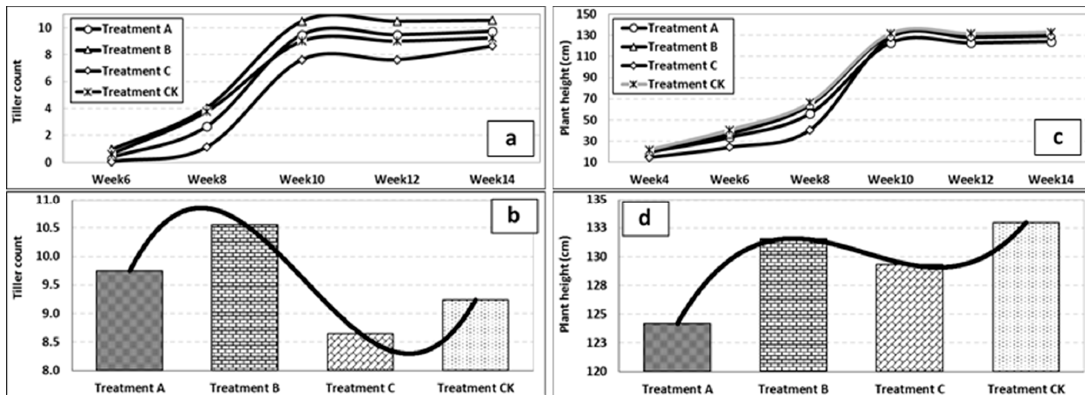
Figure 3. Number of tillers from the 6th to the 14th week (plots a & b ) and plant growth from the 4th to the 14th week (plots c & d ) of planting of New Rice for Africa (NERICA)-4 rice plant in 3 biochar application depths plus the control under tropical rainfed conditions. Treatments A, B, and C respectively denote the 10, 20, and 30 cm biochar application depths and then non-biochar treatment (CK) is the control.